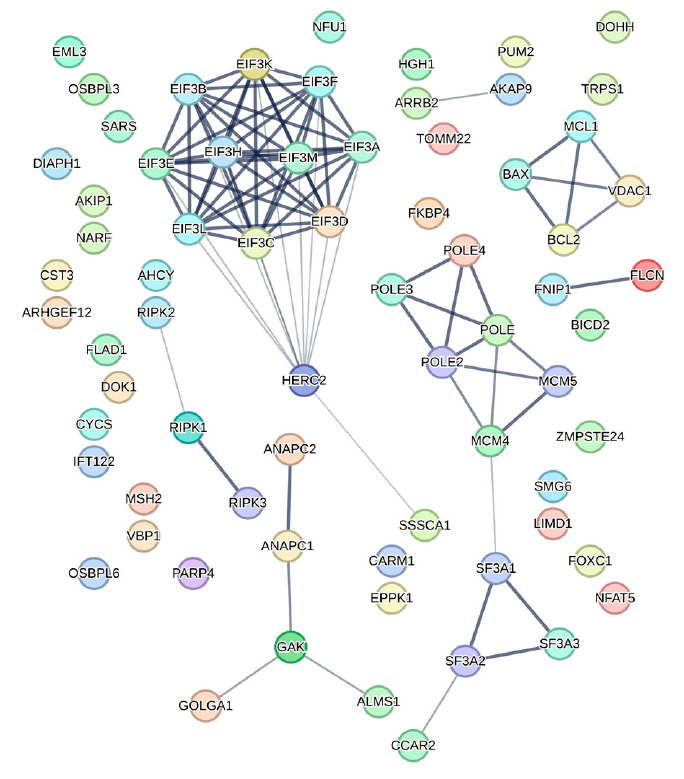
Figure 5. Graph of identified HIV-1 PR interactors from Jäger et al. represented by STRING [54].